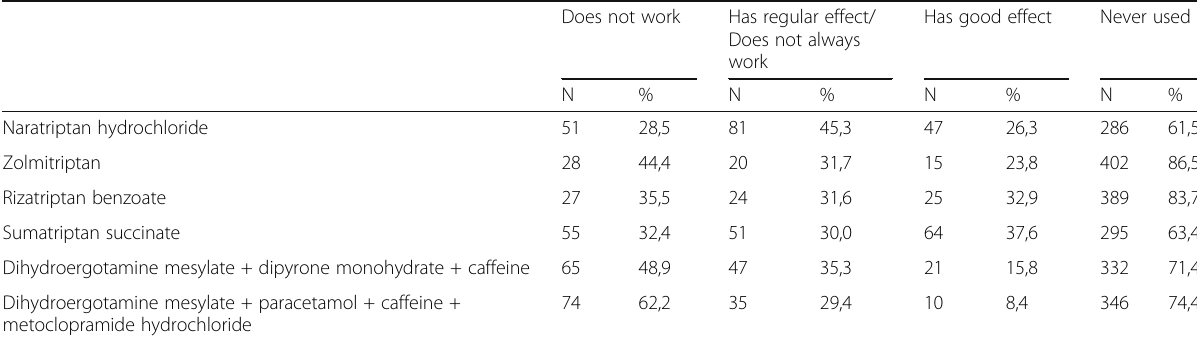
Table 6 Patients ’ experience with triptans/ergotamines